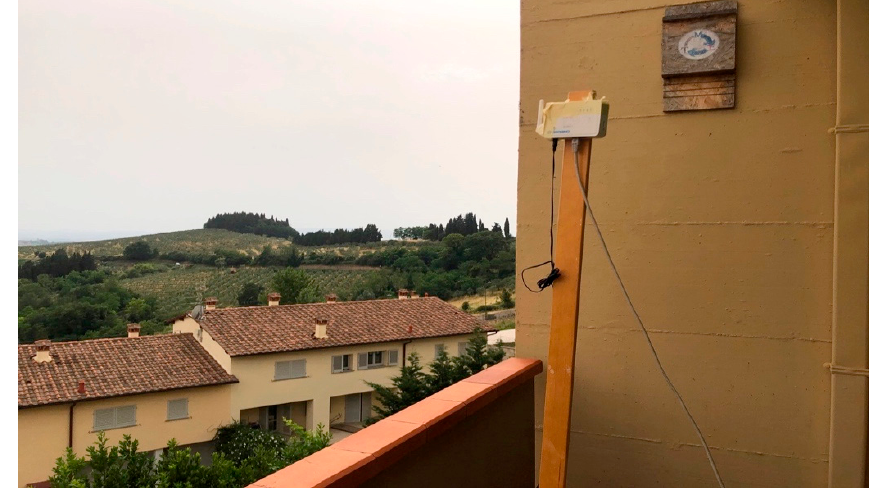
Figure 13. Gateway setup.